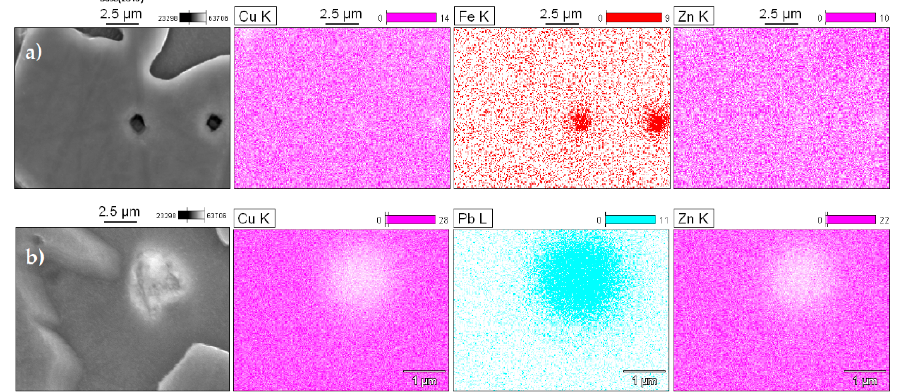
Figure 5. Qualitative scanning of the energy dispersive x-ray spectroscopy (EDS) map in particles emphasizing high concentrations of ( a ) iron and ( b ) lead.